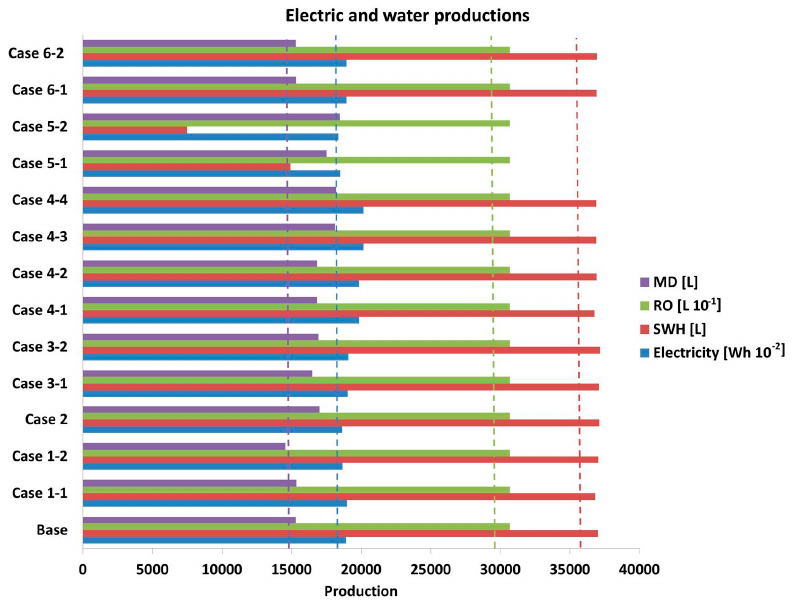
Figure 11. Yearly productions in parametric simulations. Table 8. Yearly productions table in the sensitivity analysis.